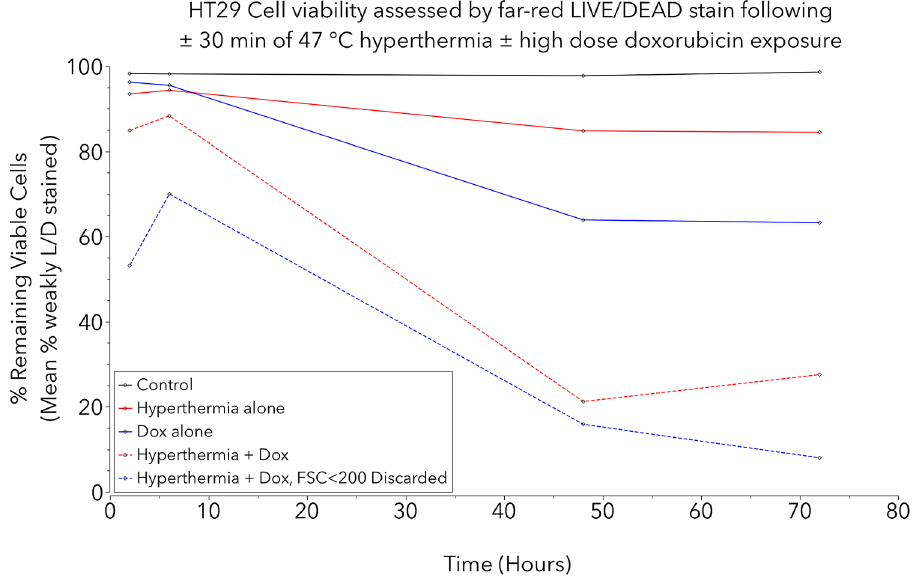
Figure 5. Summary plot of cell viability analysis for HT29 cells exposed to insults of either high dose doxorubicin (100 µg/mg) and/or 47 °C hyperthermia with controls, using L/D viability stain. Cells assayed at 2, 6, 24 48 and 72-h. There is more rapid and near-complete cell death in the group receiving both insults compared with the groups receiving a single insult, and minimal cell death is demonstrated in the control. Of note, if debris particles considered to be ‘apoptotic bodies’ are excluded, the results indicate near-total cell kill in the group receiving both insults at 72-h (blue dotted